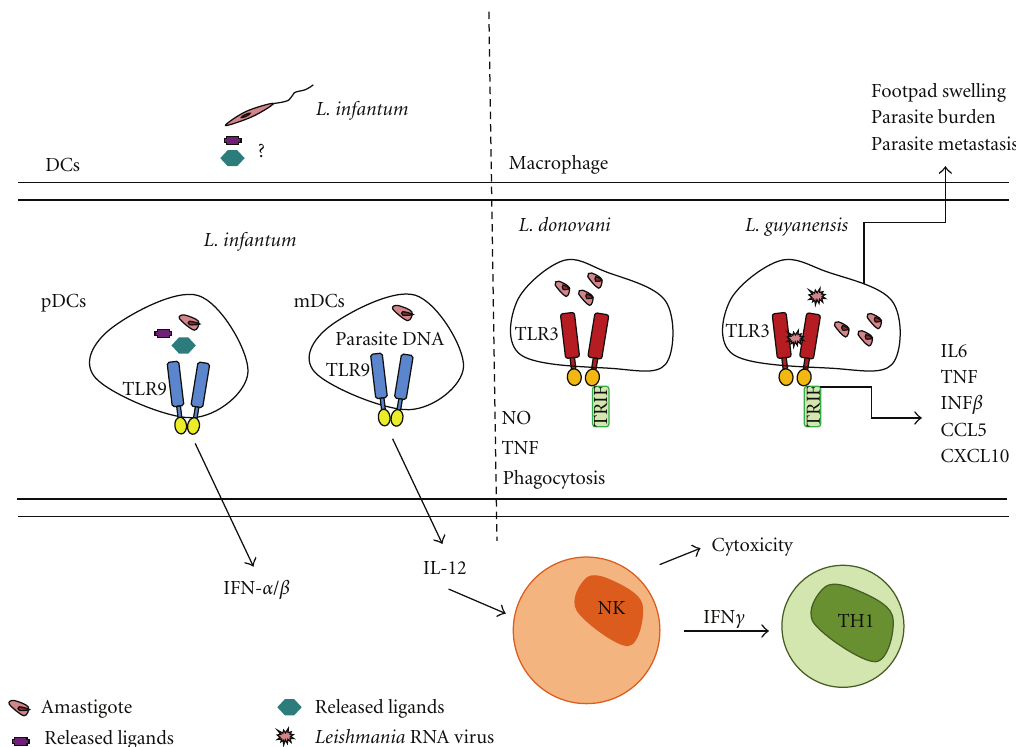
Figure 3: Proposed models for the activation of intracellular TLR9 and TLR3 by Leishmania . TLR9 of plasmocytoid DCs (pDCs) can be activated by putative TLR9 ligands secreted by L. infantum promastigotes and taken up by endocytosis or in endosomal compartments. TLR9 in myeloid DCs (mDCs) can be activated by L. infantum DNA after parasite phagocytosis and destruction in the endosomal compartment, leading to the activation of NK cells and protective Th1 responses [4, 63, 64]. TLR3 is required for the production of TNF, NO and the phagocytosis of L. donovani by macrophages, suggesting a protective role for infection [67]. Intracellular TLR3 is activated in a TRIF- dependent pathway in macrophages infected with metastatic L. guyanensis , by double-stranded RNA from the Leishmania virus LRV1 [68]. This leads to the production of proinflammatory cytokines and chemokines, as well as type1-IFNs. Despite the inflammatory response, TLR3 is required for the e ff ective development of footpad swelling, for significant parasite burden and its dissemination in infected hamsters, suggesting that TLR3 activation facilitates disease pathology by parasites of the Leishmania Viannia